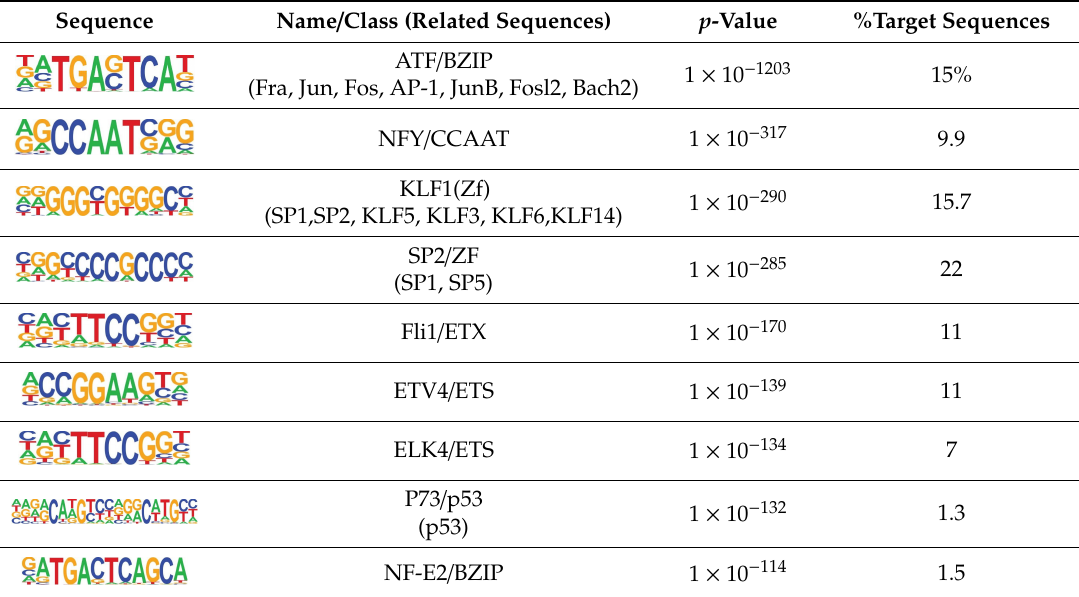
Figure 5. Presence of active enhancers in ATAC-Seq peaks. Venn diagram of the overlap between the high confidence ATAC-Seq peaks from uninfected hSAECs and active A549 enhancer sequences. 3.5. Promoter-Enriched Open Chromatin Domains Are Enriched in Basic Domain-Leucine Zipper (bZIP) Binding Motifs A combinatorial code of cis regulatory elements on gene promoters confers cell-type and virus- inducible gene expression patterns by binding cognate transcription factors regulated by distinct signal transduction pathways. To identify if there are similar patterns of cis regulatory elements in open promoters, we systematically searched for enrichment of known motifs. For this purpose, we used HOMER, an algorithm that identifies motif enrichment relative to random DNA sequence matched for similar guanosine-cytosince (GC) content [24]. Over 150 highly significant motifs were identified, including members of the activator protein 1 (AP-1) complex, nuclear transcription factor Y (NFY), Kruppel Zinc Finger (KLF), specificity protein 1 (SP1) transcription factor binding sites, and others (Table I). Interestingly, these factors are found at a significant fraction of the chromatin regions, with AP-1/ATF binding sites in 15% of regions, KLF in 16%, and SP2 in 22% of regions (Table 1). Table 1. Motif analysis.